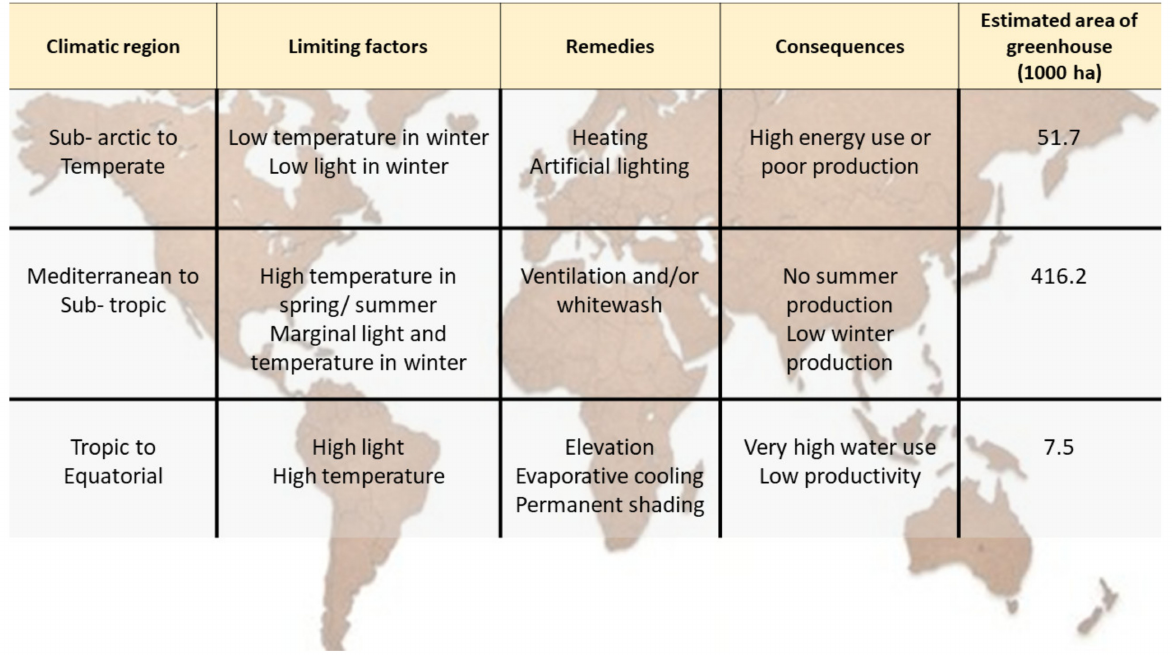
Figure 2. Limiting factors of greenhouse cultivation, remedies, consequences, and estimated area of greenhouses in the main climatic regions of the world